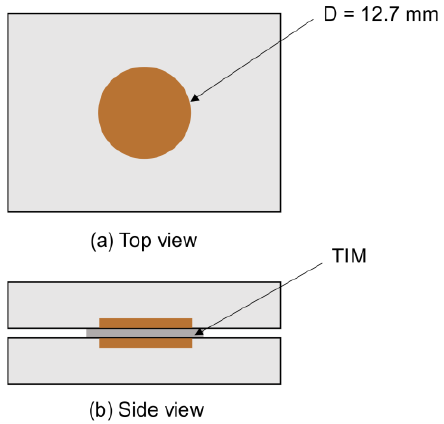
Figure 6. ( a ) Conductive plates on the electrode, ( b ) TIM placed in between the electrodes.